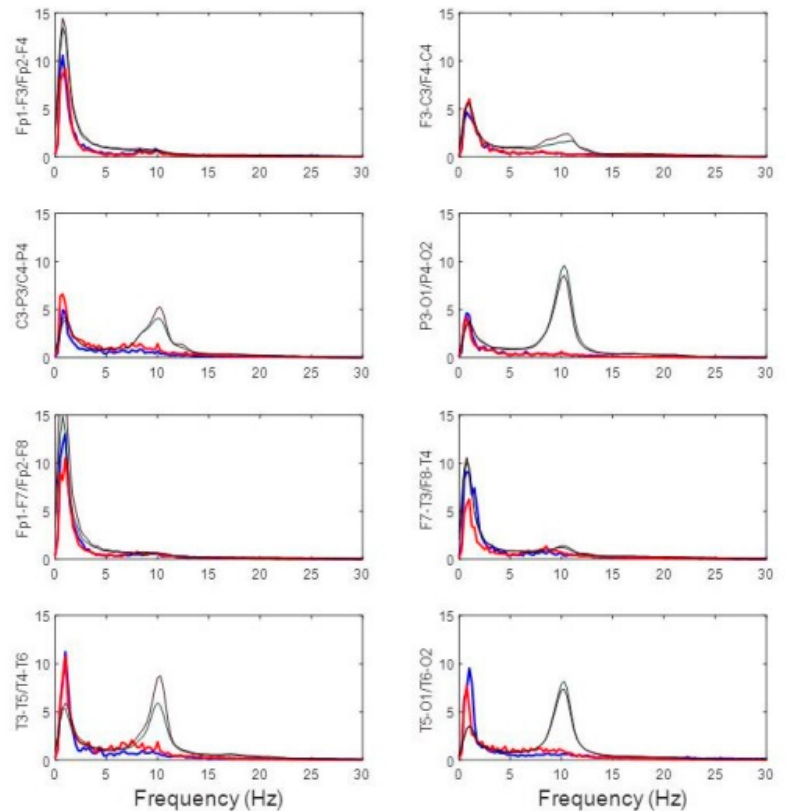
Figure A1. Comparison of mean power spectrum for channels between a COVID patient (#8) and the mean spectra pooled from 30 healthy volunteers, normalized to the maximum amplitude of delta band at central regions. Red and blue lines indicate right and left hemispheres for the COVID patient respectively and black lines represent the volunteers group. Y-axis units in µV 2 /Hz. Pay attention to the great difference for alfa/beta bands.